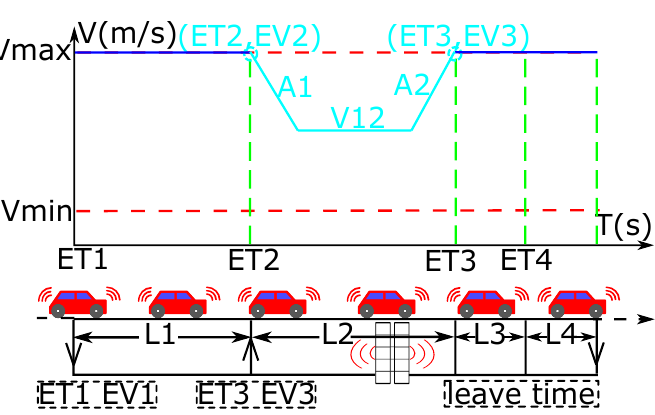
Figure 2. Process of traversing a communication